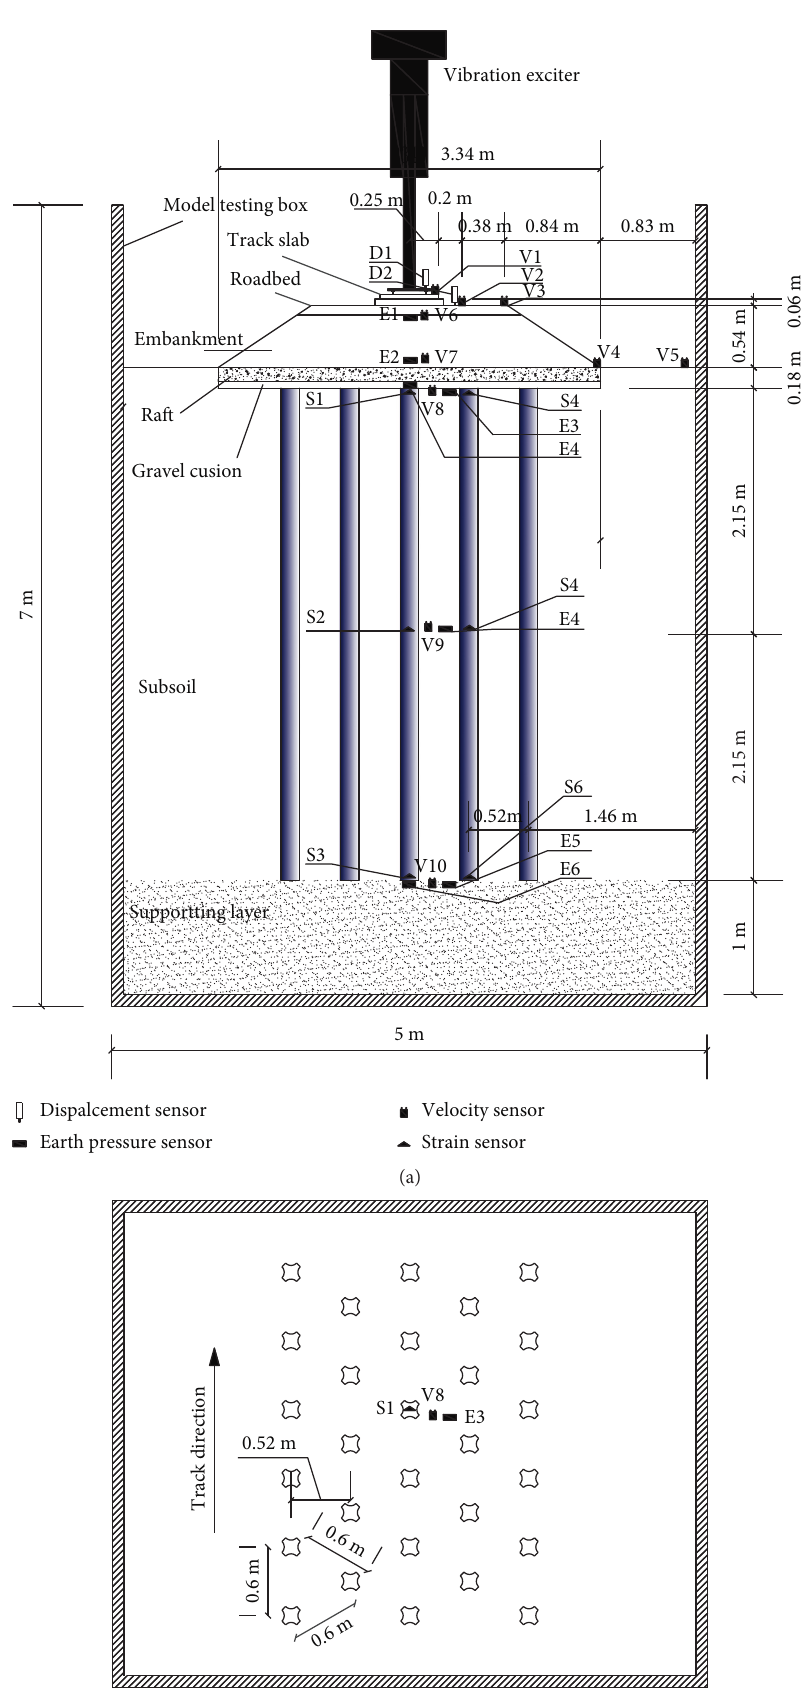
Figure 2: Layout of instruments for model test in dynamic loading system. (a) Cross-sectional view. (b) Plain